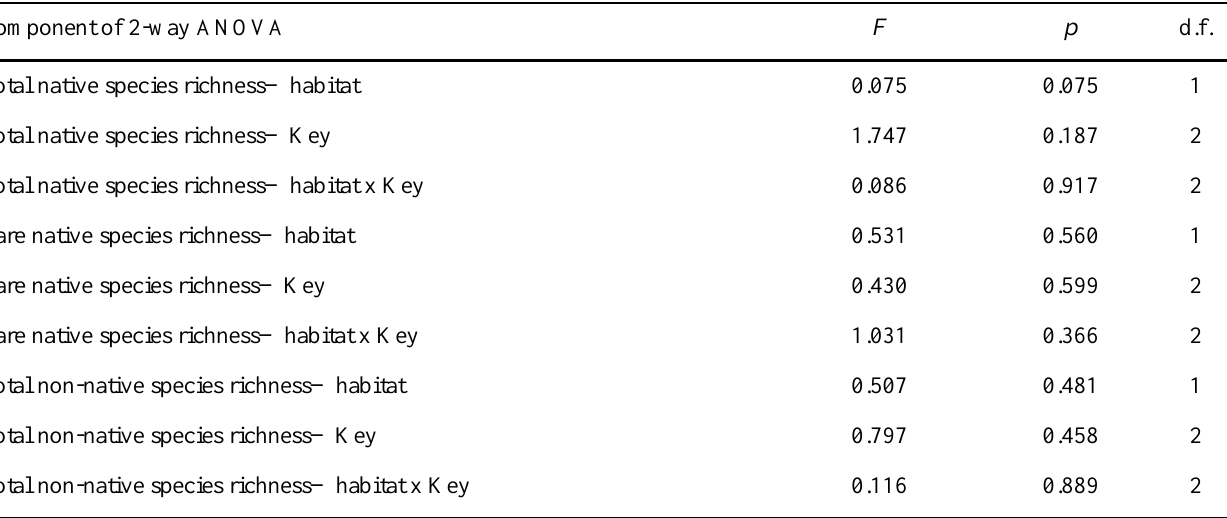
Table 1. Results of two-way ANOVAs that tested the influence of habitat type and key on the number of total native species, rare native species, and non-native species at each site in the Lower Florida Keys Component of 2-way ANOVA F p d.f. Total native species richness—habitat 0.075 0.075 1